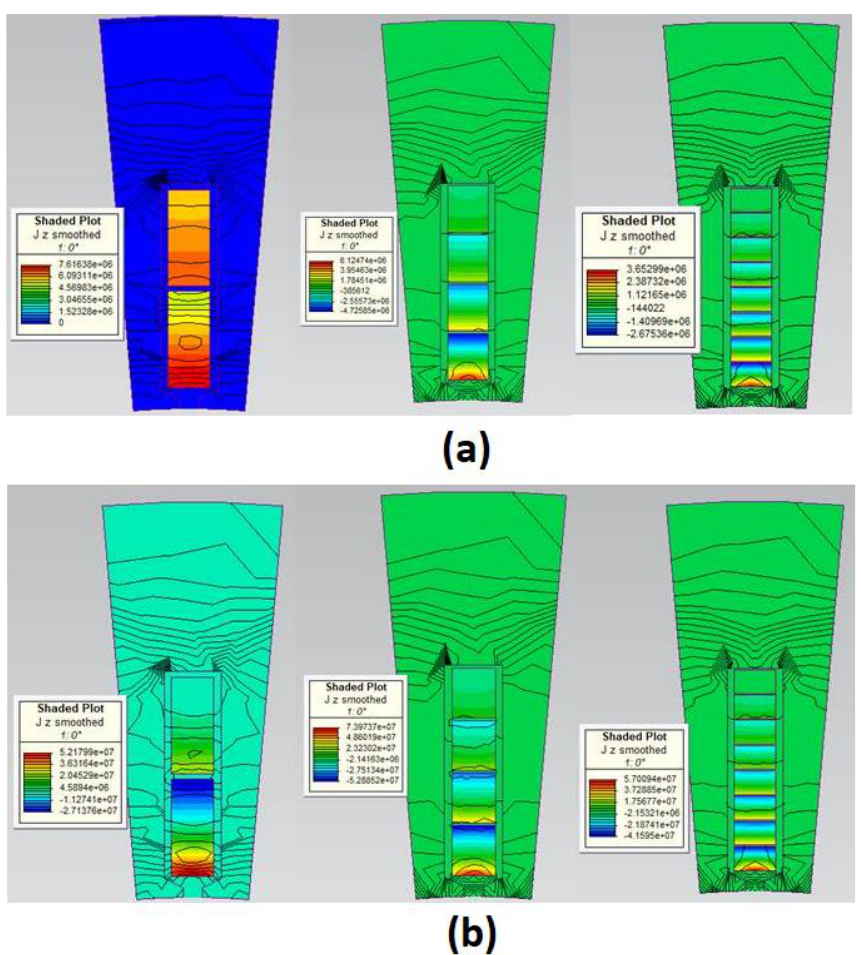
Figure 9. Current density distribution in the Z direction and the flux density distribution for two-layer, four-layer, and eight-layer conductors ( a ) at 50 Hz and ( b ) 800 Hz.